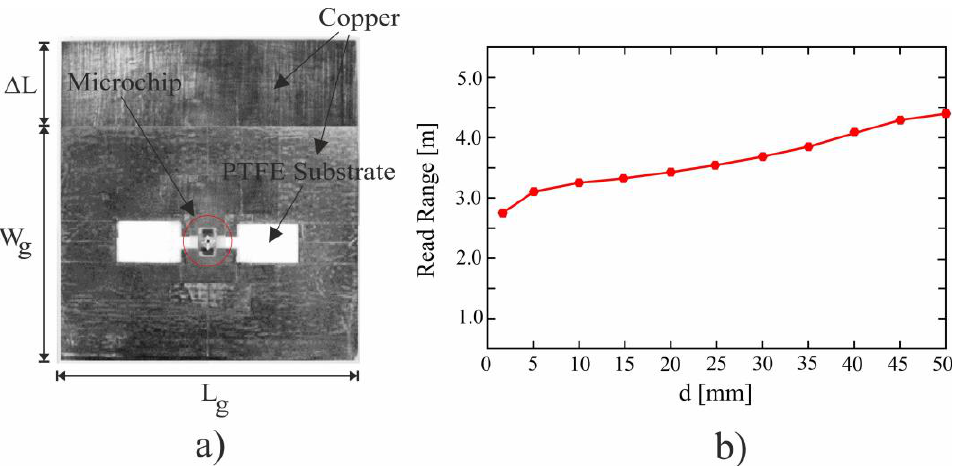
Figure 17. ( a ) Prototype of the antenna in Figure 3d, with ∆ L = 30 mm, W g = 49 mm, L g = 60 mm. ( b ) Measured read range of the antenna under test. Table 1. Measured read range of the antenna under test for 10 different measure campaigns. For each antenna distance from the body phantom, the mean value (in green) and the standard deviation (in red) are reported.